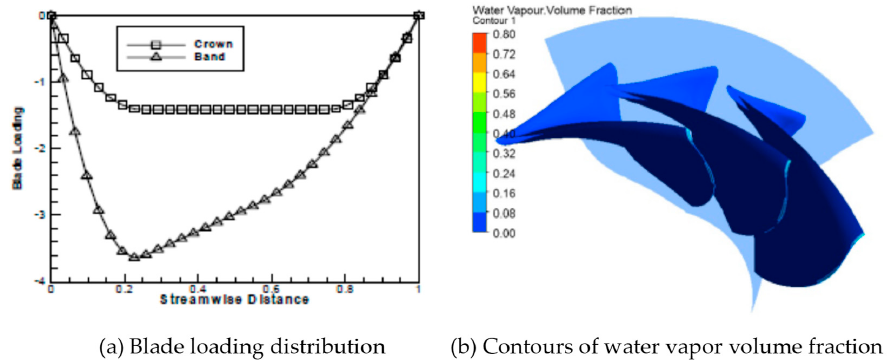
Figure 11. Suppression of cavitation based on blade loading control [13].